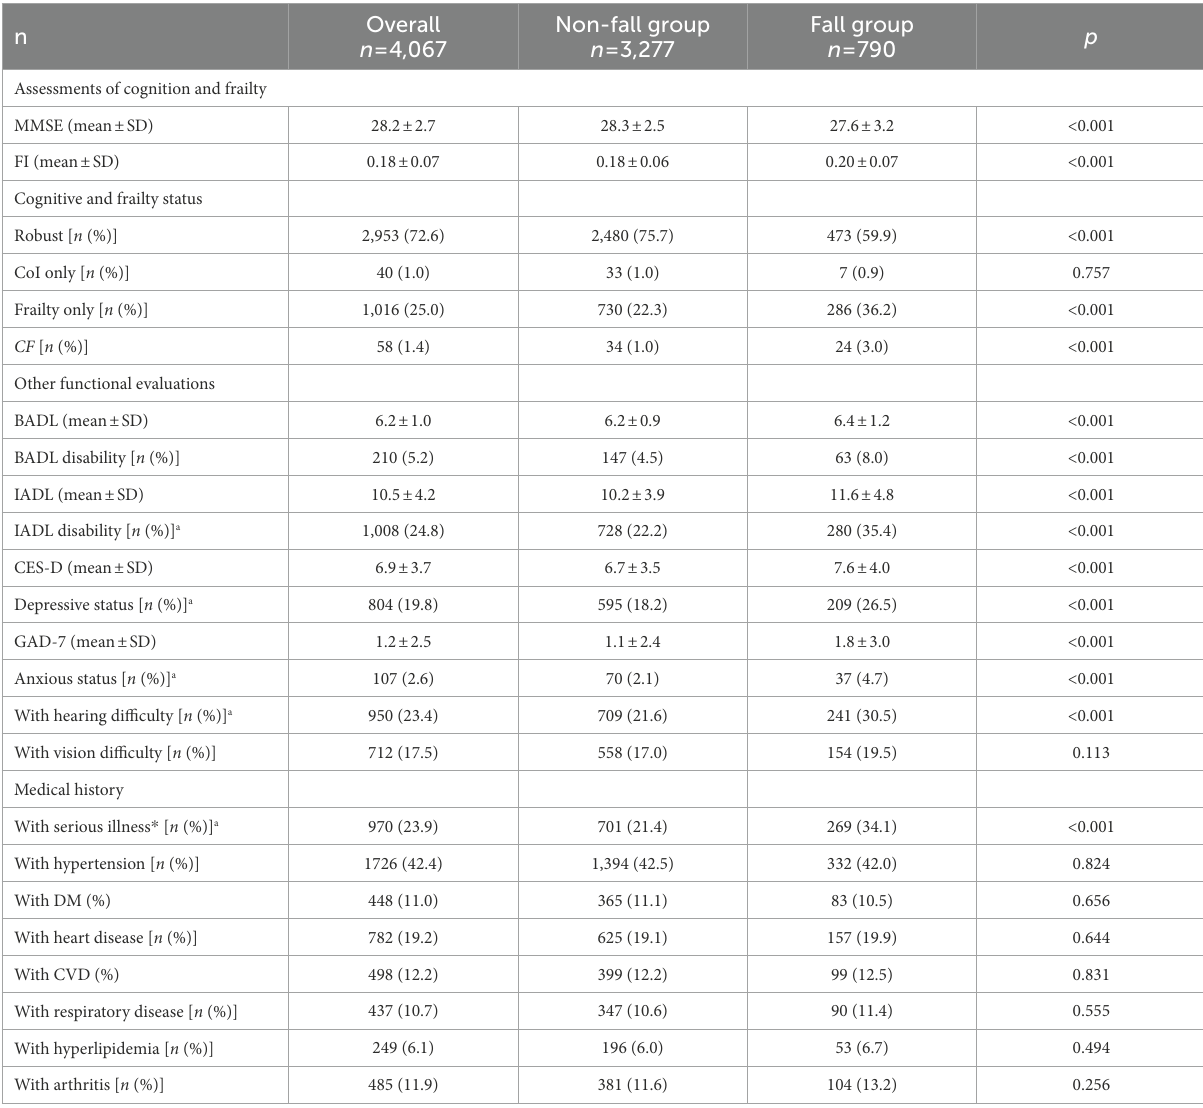
TABLE 2 Functional status and medical history between